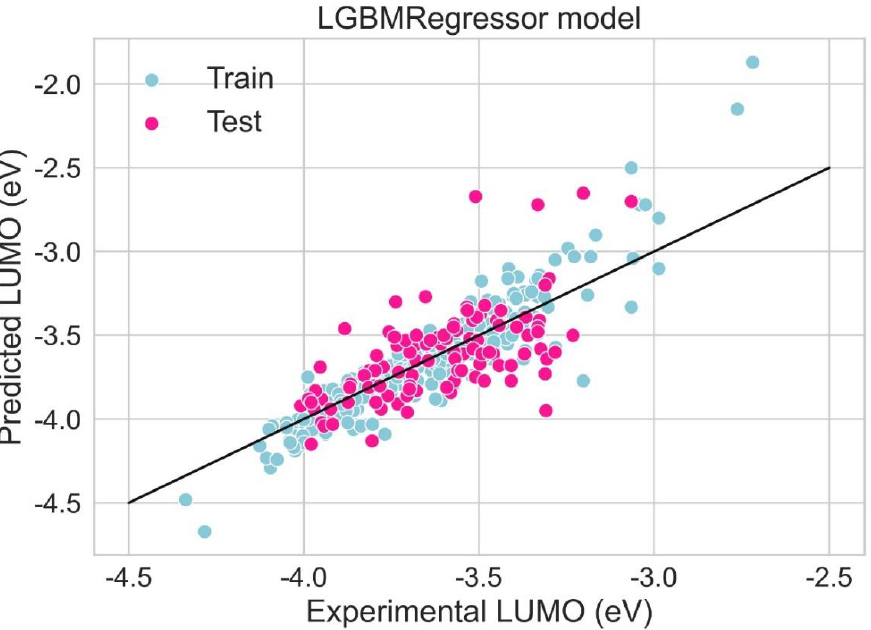
Figure 15. Scatter plot between experimental and predicted HOMO using LGBM regression model.